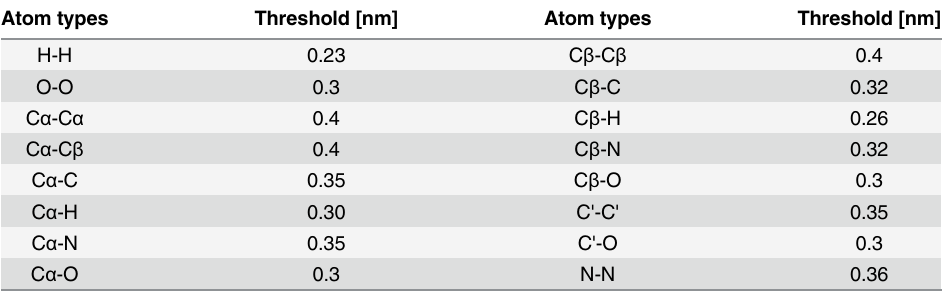
Table 1. Atom pair self-avoiding sphere distances, d , from Eq